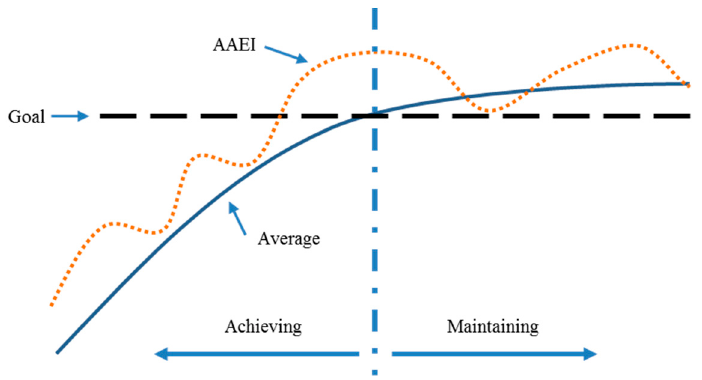
Figure 6. The principle of prompting decision making. The AAEI should be above average line in the goal achieving phase and the average line should above the goal in the maintenance phase.